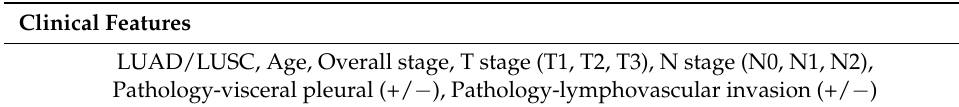
Table 2. Clinical variable used in the first neural network model. Clinical